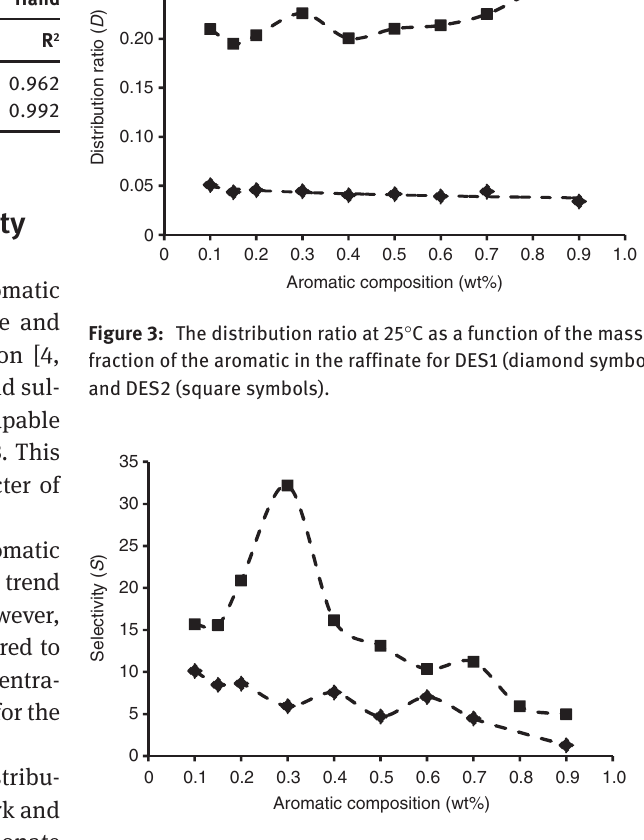
Table 4: Othmer-Tobias and Hand correlation parameters. Othmer-Tobias Hand